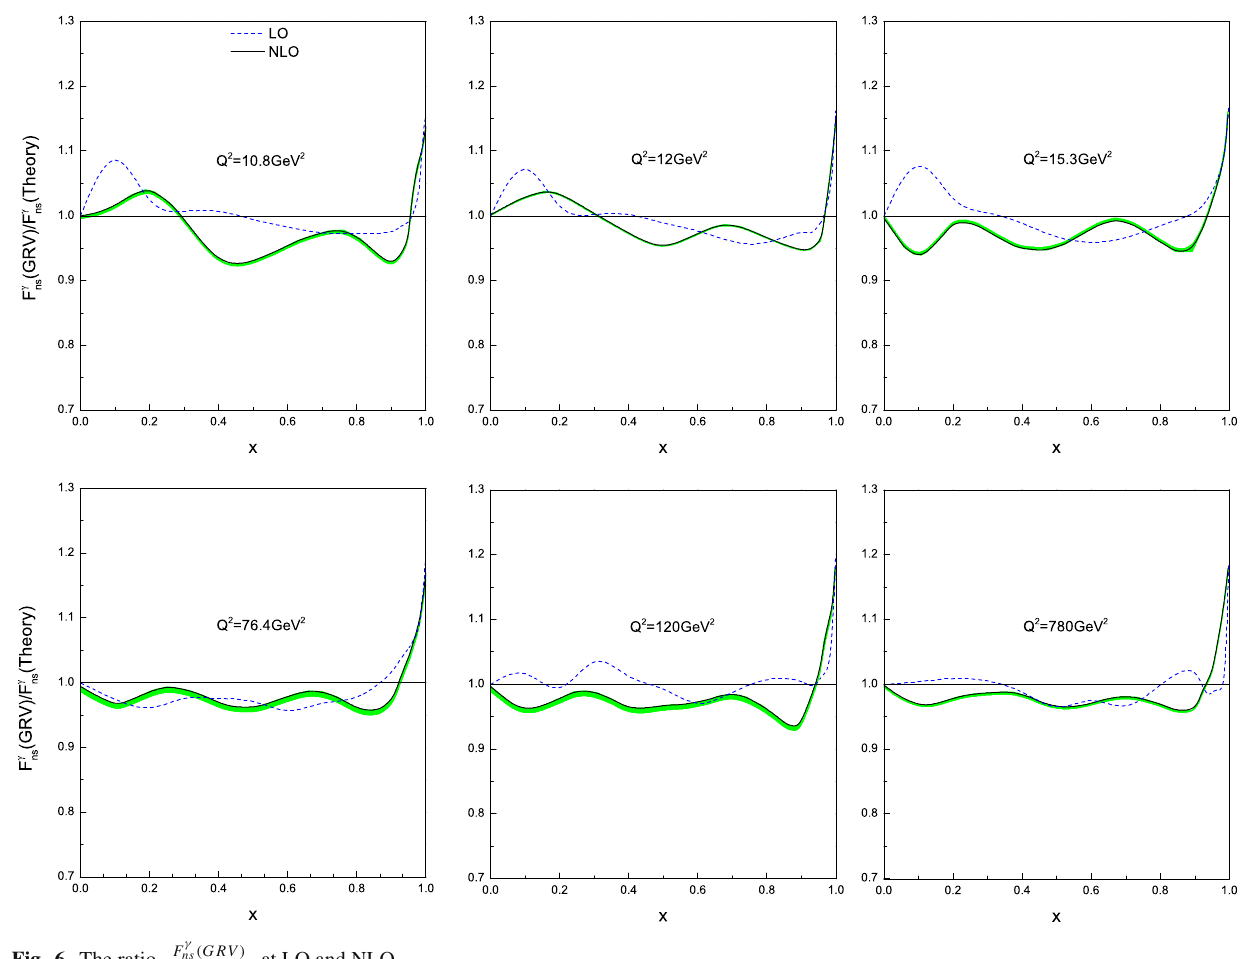
Fig. 6 The ratio F